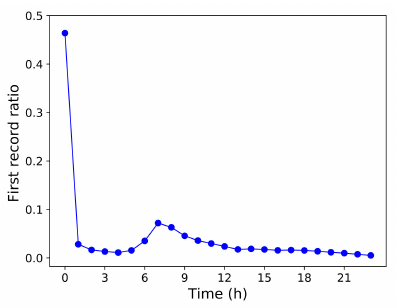
Figure 6. Proportional distribution of the first record at the hour level.